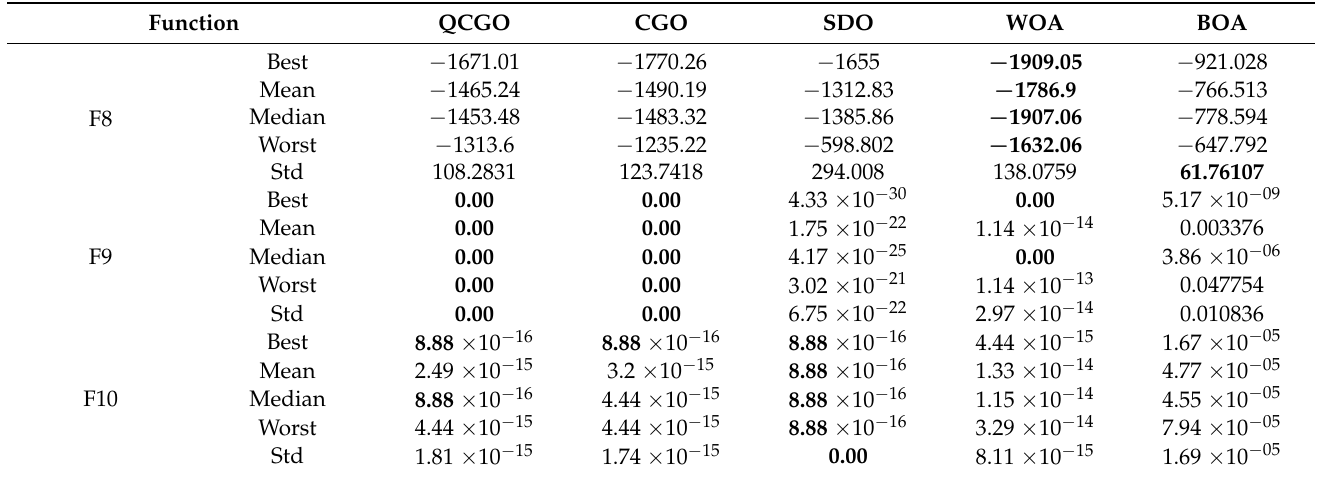
Table 5. Results of multimodal benchmark